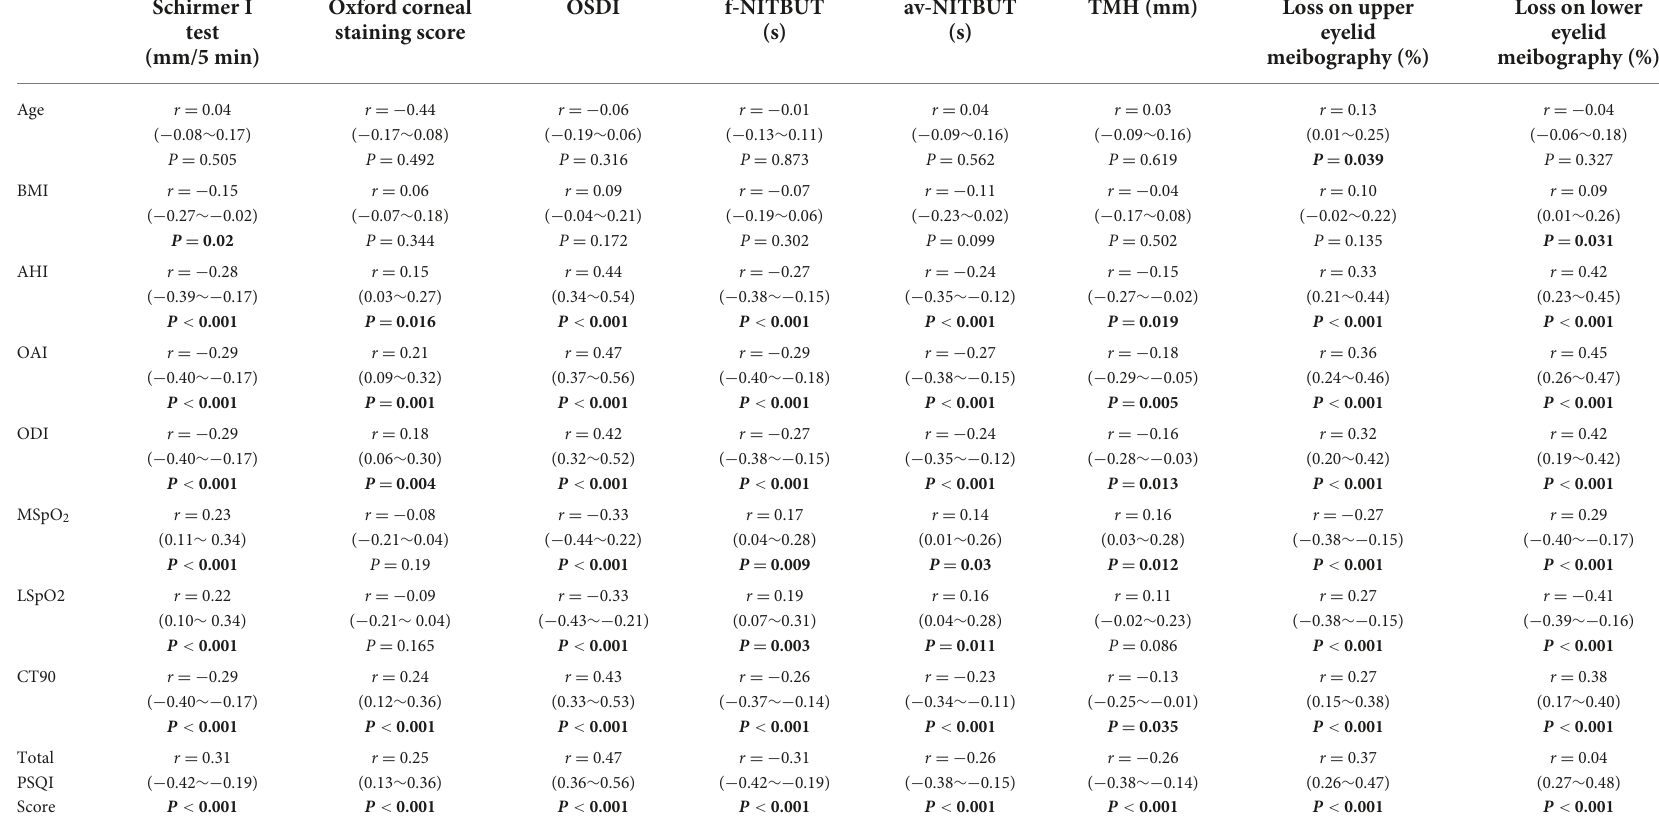
TABLE 3 Correlation analyses of DED-related ophthalmologic parameters and relevant factors, including general information, OSA parameters, and sleep quality among all the